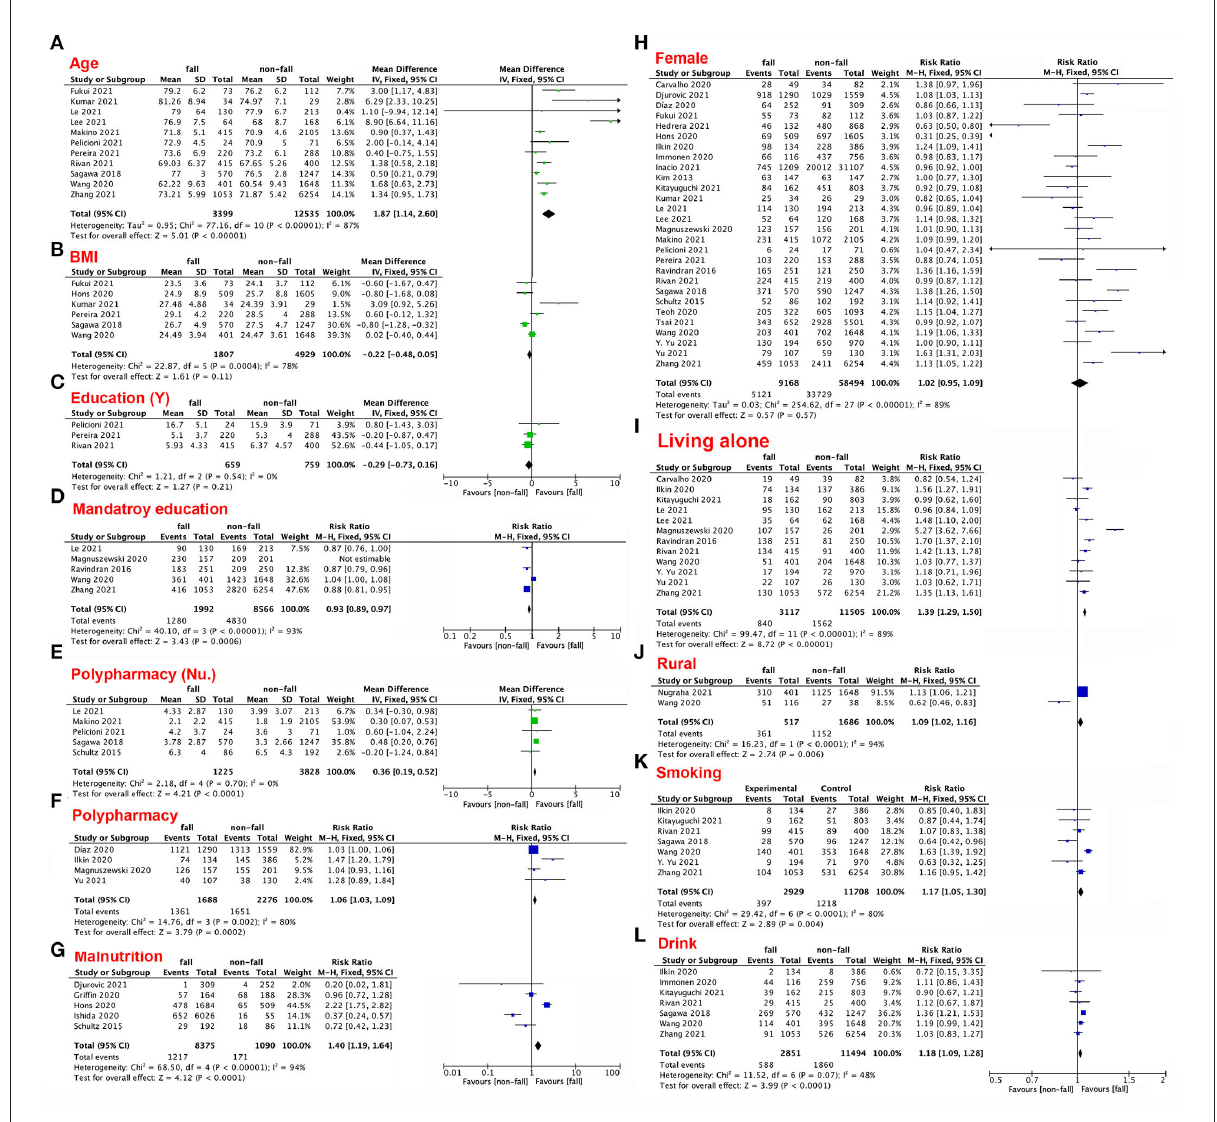
FIGURE2 (A–L) Forest plots of the impacts of patient characteristics and lifestyle factors on the risk of falls.